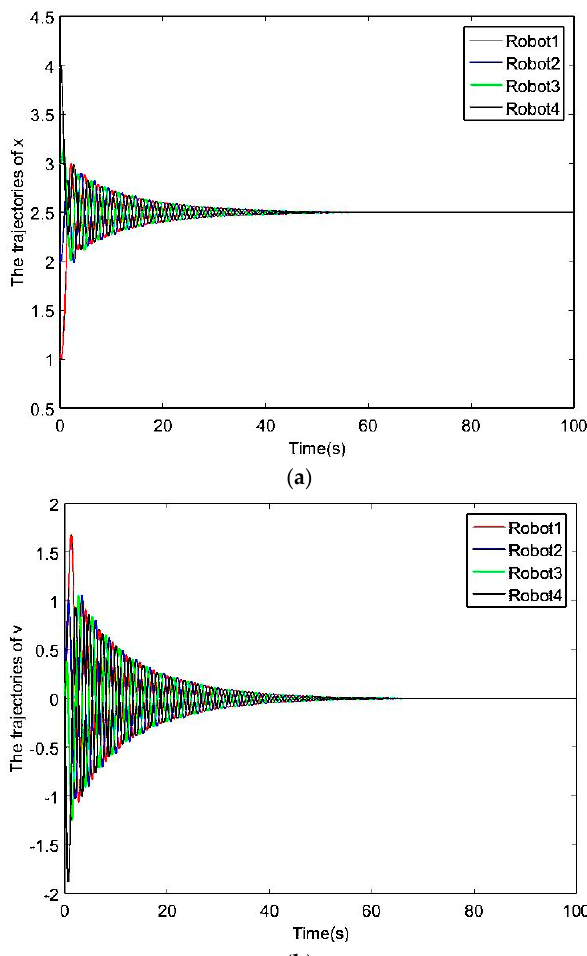
Figure 5. Experiment 2 Group 1 simulation results; x is position, v is velocity. ( a ) Trajectory of x changing with time; ( b ) Trajectory of v changing with time.